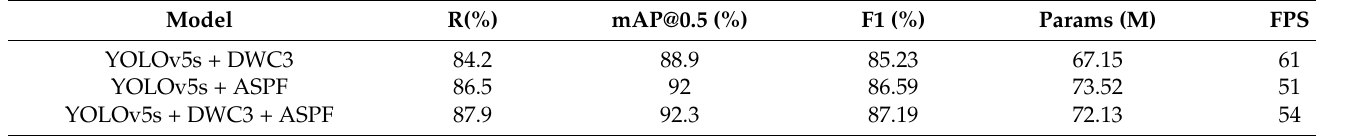
Table 1. Effect of different network structures on the detection effect of the